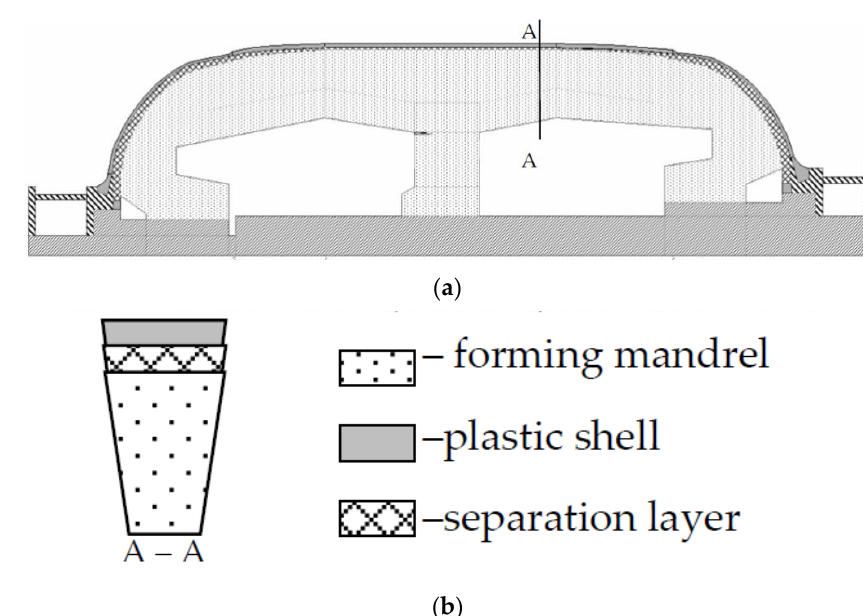
Figure 1. Computational scheme of the structure: ( a ) schematic of the real structure; ( b ) test model.